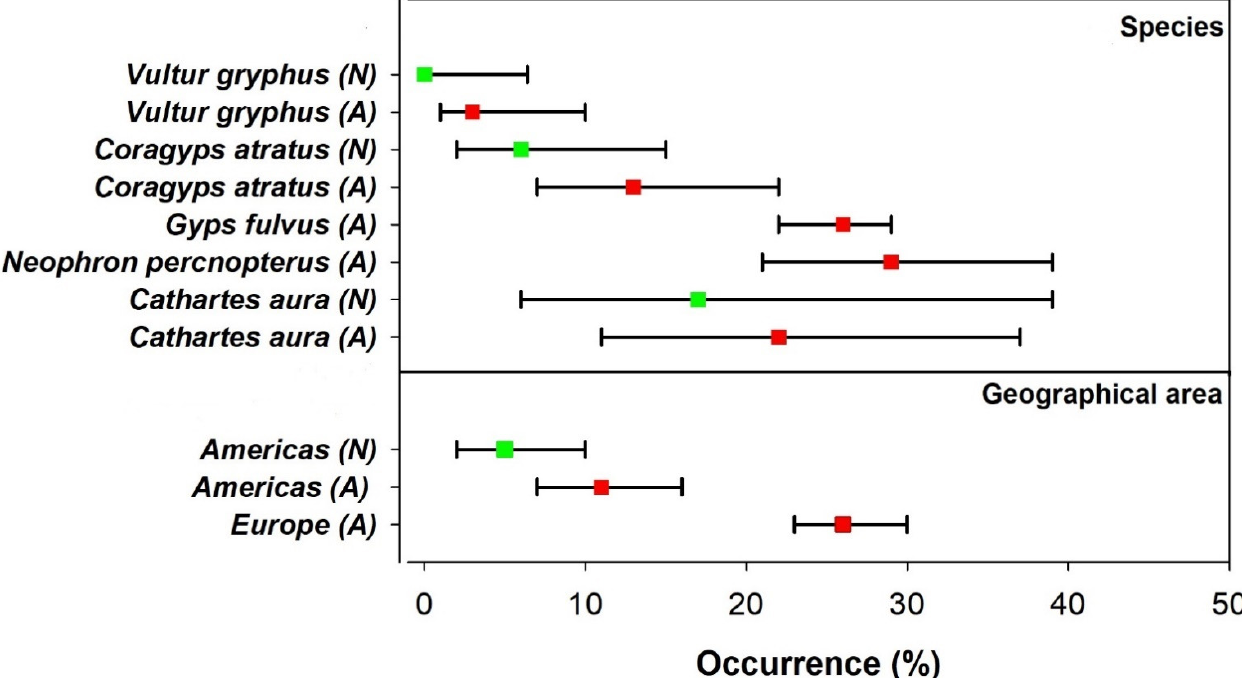
Figure 2. Occurrences (±95% CI) of Salmonella spp. according to the environment where different vulture species were sampled indicated as natural ( N ) or anthropized ( A ). The upper part of this figure presents occurrences according to species. Large 95% CI are mainly a result of small sample sizes of the study on a species (Table S1). The lower part of the figure presents occurrences according to the environment and geographical areas (pooling the species). Occurrences for N. percnopterus and G. fulvus (European species) are shown separately from American species ( V. gryphus, C. aura and C. atratus ) because the first two species have only been studied in highly anthropized environments (Table S1).